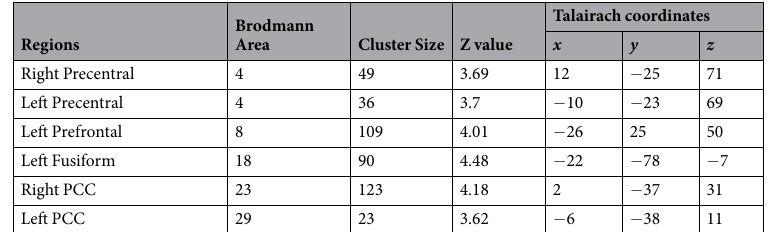
cortex, left fusiform cortex, and bilateral posterior cingulate cortex (PCC; Fig. 2). When the five PI patients who did not complete the follow-up MRI scan were included in the analysis, all areas other than the left precentral cortex remained significant. According to these results, six regions of interest (ROIs) were defined as the voxel clusters showing significant between-group differences in BOLD signals in response to SS. The BOLD response to SS in the left precentral cortex of PI patients correlated positively with WASO in sleep diaries (r = 0.664, p = 0.020).